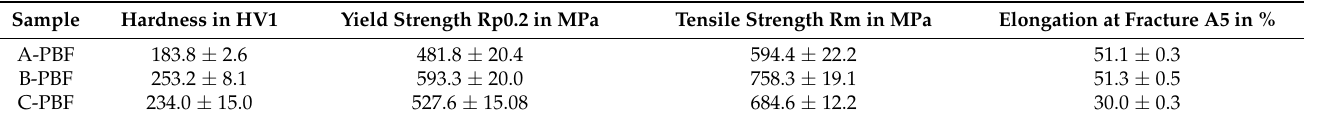
Table 7. Mechanical properties of the PBF-LB/M-processed samples.